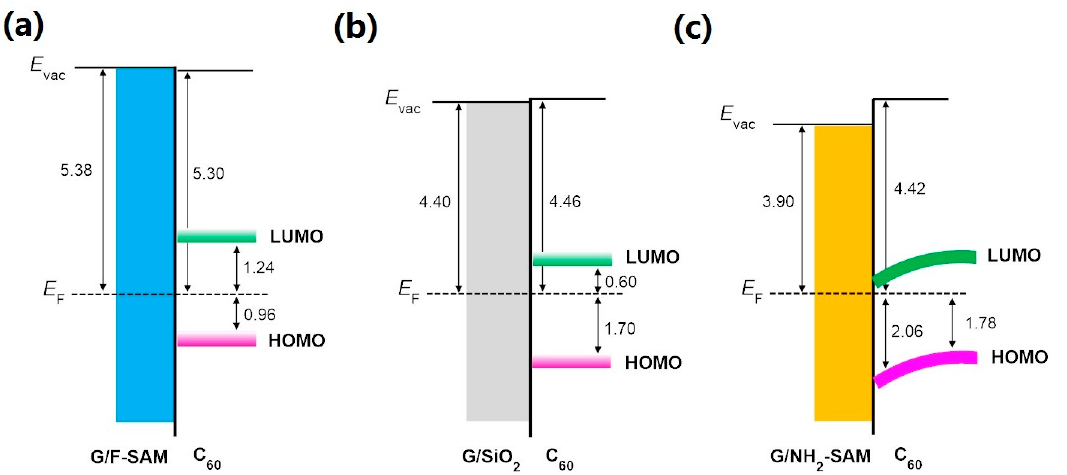
Figure 6. Energy level diagrams of ( a ) C 60 / graphene on F-SAM, ( b ) C 60 / graphene, and ( c ) C 60 / graphene on NH 2 -SAM.